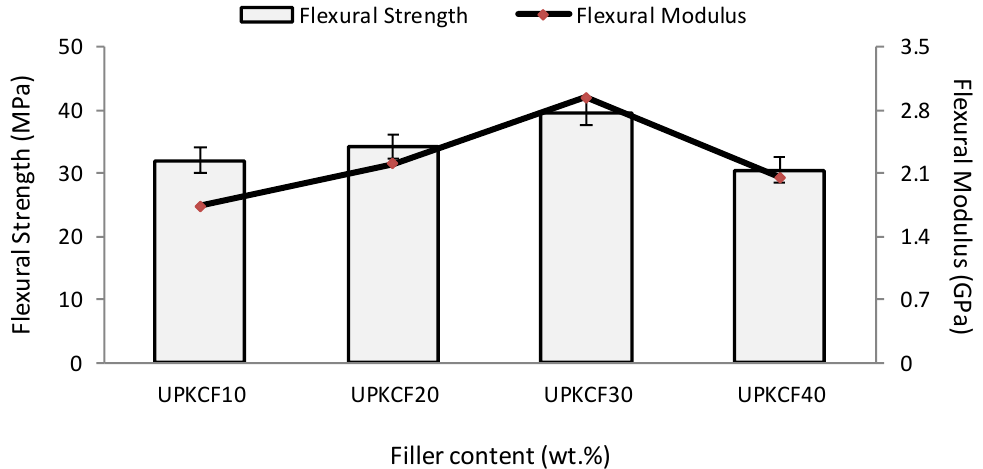
Figure 6. Flexural strength and flexural modulus of UPKCF/ER composites. Table 5 gathers comparable results on the effect of filler concentration and size on the composites’ flexural properties from past research. From the table, the size of the fillers used to reinforce the polymer epoxy resin ranges from 2 µ m to 30 mm. The optimal weight concentration of the filler used in the composite ranges from 10% to 50%. Several parame- ters, for instance, the filler size, the filler type, the filler concentration, and the interfacial adhesion between the fillers and the matrix, are thought to influence the composites’ flexu- ral capabilities [33,36–38,40,43,44]. The highest flexural-strength value in this investigation is almost identical to that found in earlier experiments, ranging from 41 MPa to 53.4 MPa. Table 5. Reported previous studies on flexural properties of various filler-reinforced epoxy composites. Optimum Filler Loading